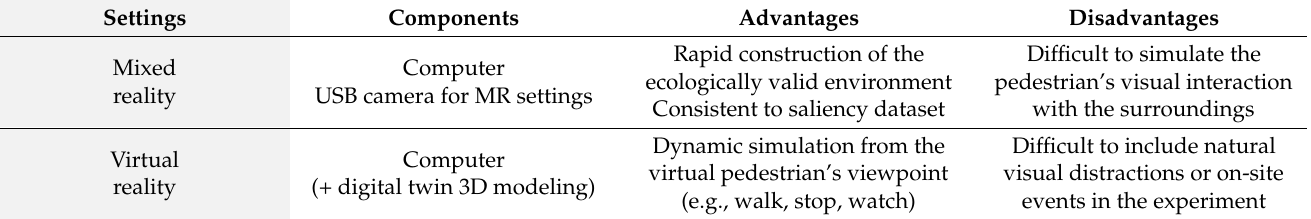
Table 3. Advantages and disadvantages of our method and previous methods of urban design feedback.